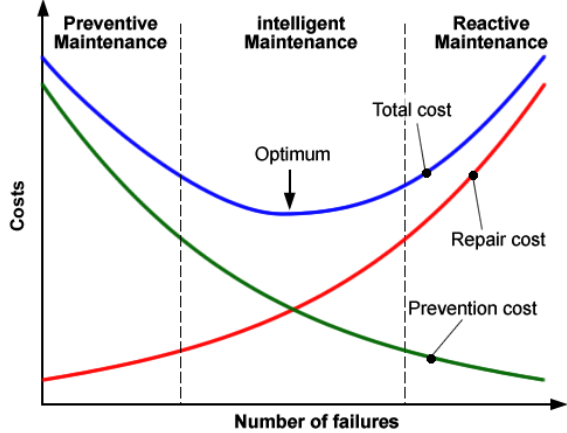
Figure 6. Costs associated with traditional maintenance